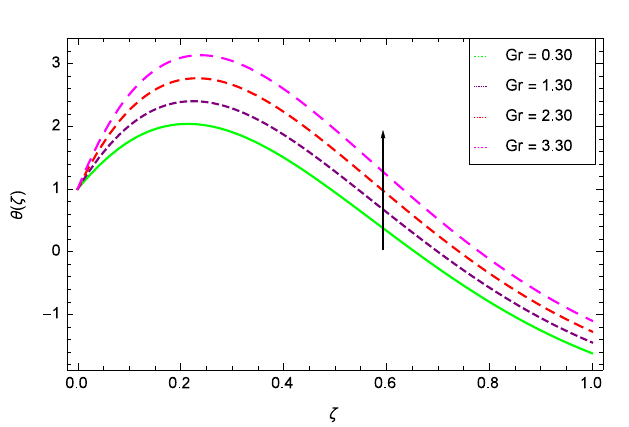
Figure 23. Parameter effect on heat transfer θ ( ζ ) profile.